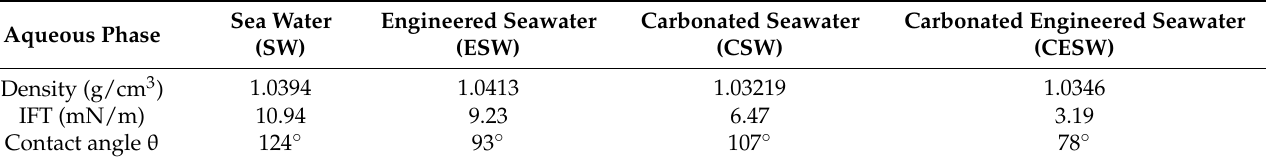
Figure 1. HP-HT pendant-drop IFT/contact angle set up. Table 4. Density of brines and oil-brine IFT at 100 °C and temperature and 500 psi pressure.